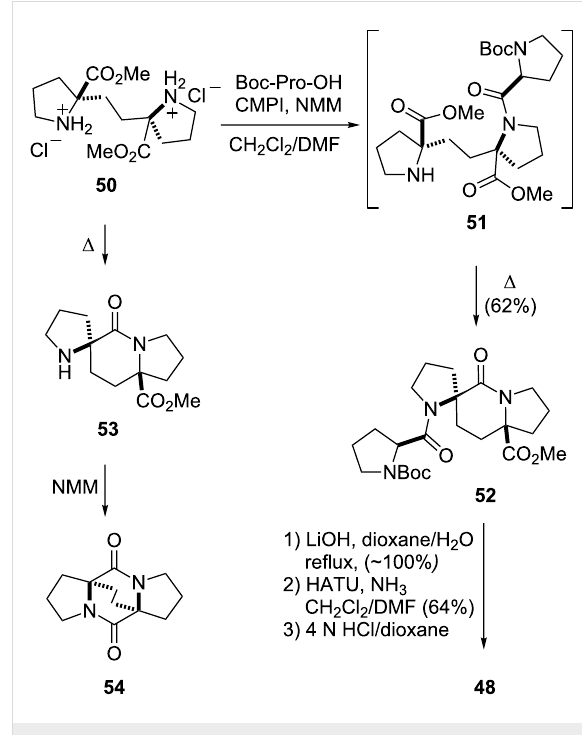
In the retrosynthetic analysis of spiro-bicyclic type VI β -turn mimic 48 , a disconnection at the lactam bond in the indolizidi- none core was envisioned, which would give rise to a symmetric unit of two prolines linked enantioselectively via a two-carbon linkage at their α -carbons [55]. Such an approach proved successful, as shown in Scheme 3. The